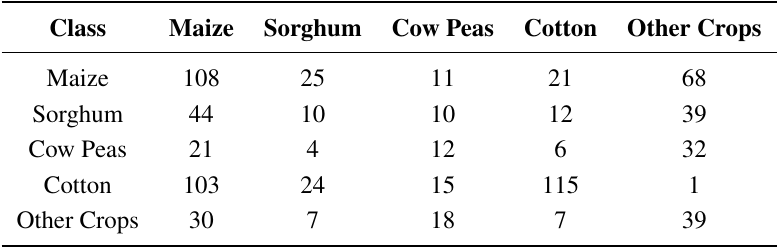
Table 8. Confusion matrix for SVM on the Burkina test